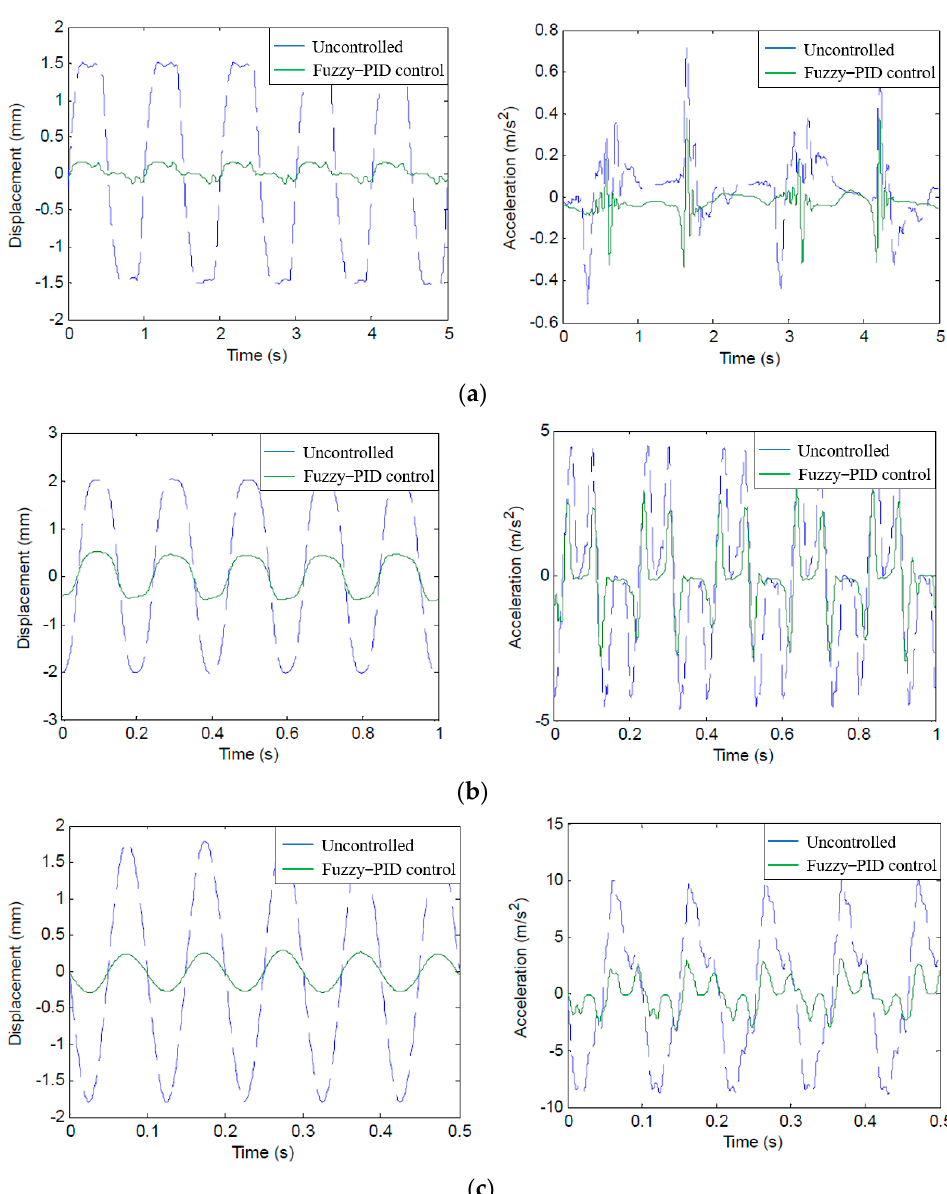
Figure 13. Pipeline vibration response under fuzzy–PID control. ( a ) Excitation frequency 1 Hz. ( b ) Excitation frequency 5 Hz. ( c ) Excitation frequency 10 Hz.